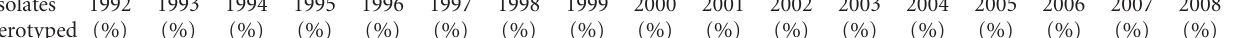
Table 2: Distribution of isolates serotyped among pneumococcal isolates sent to the NRCS in Germany (1992–2008). Isolates